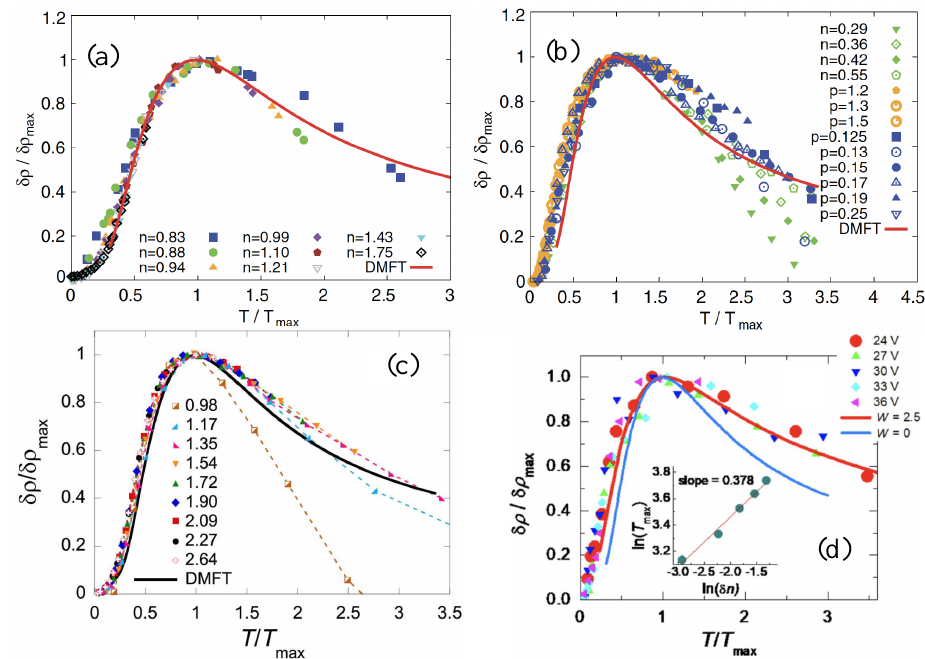
Figure 3. Characteristic scaling of the resistivity maxima has been reported in several 2DEG electron systems in semiconductors: ( a ) Si-MOSFETs (adapted with permission from Ref. [29] Copyright 2012 American Physical Society); ( b ) p-GaAs/AlGaAs quantum wells (adapted with permission from Ref. [29] Copyright 2012 American Physical Society); ( c ) SiGe/Si/SiGe quantum wells (adapted with permisssion from Ref. [30] Copyright 2020 American Physical Society); ( d ) few layered- MoS 2 (Adapted with permission from Ref. [32] Copyright 2020 American Physical Society). All data collapse to the same (theoretical) scaling function [29] obtained from the Hubbard model at half-filling, in the vicinity of the Mott